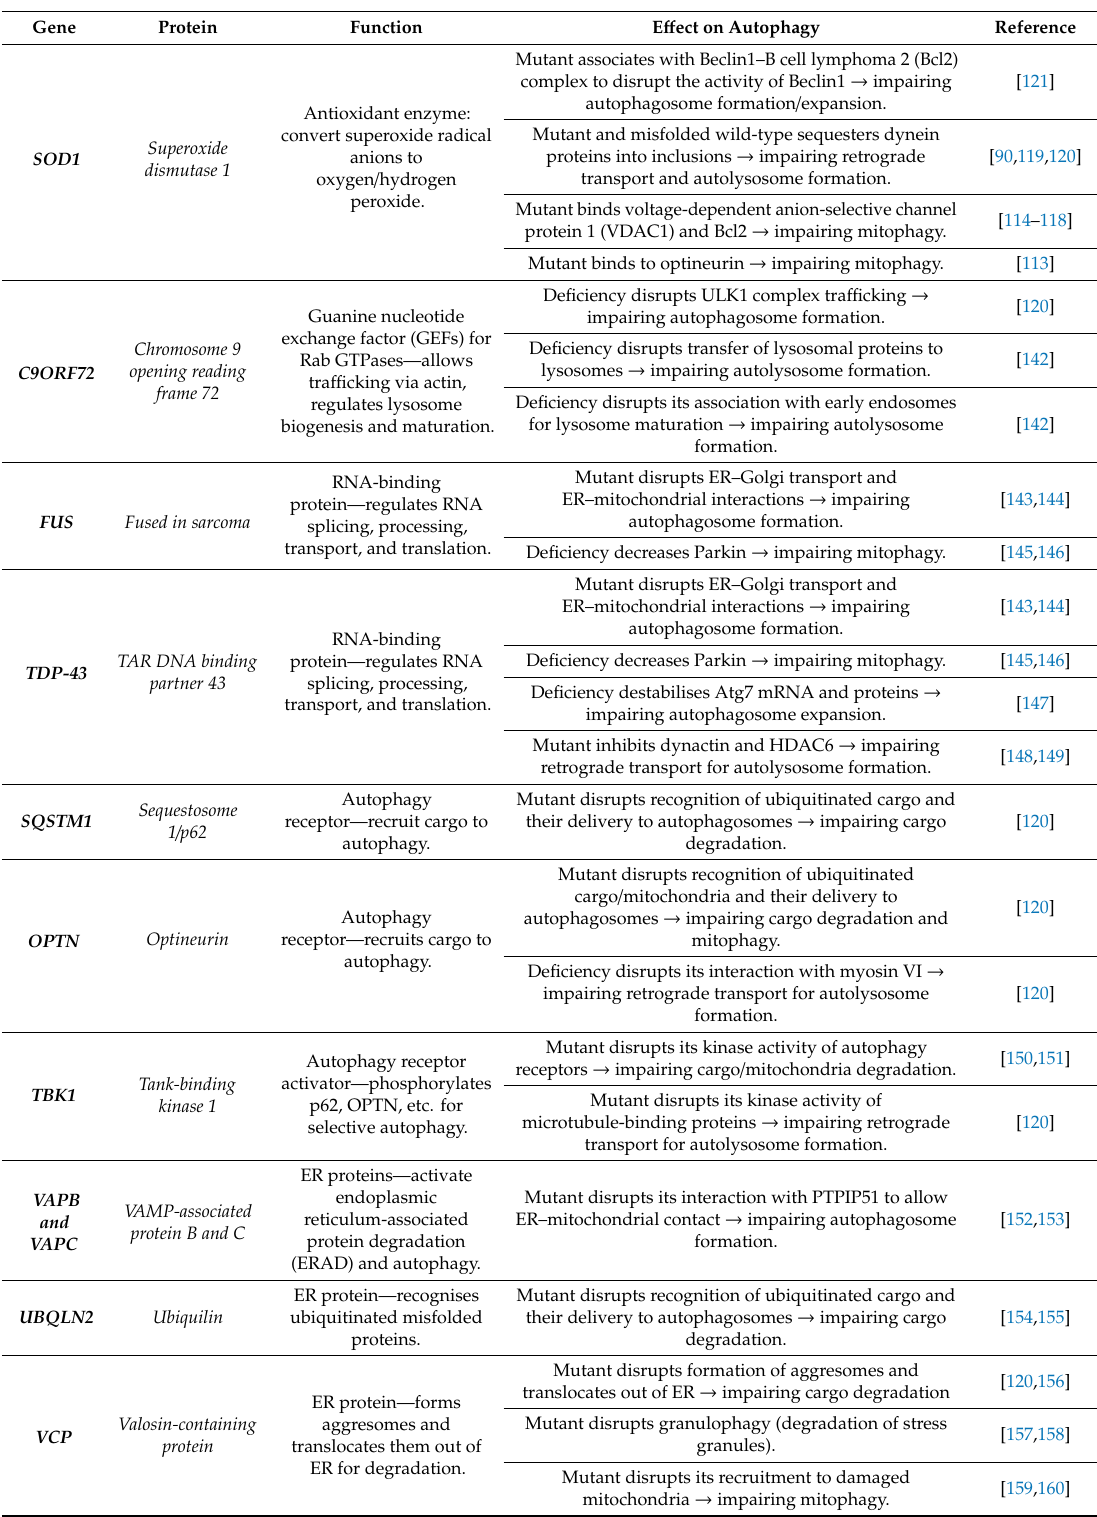
Table 1. The association between ALS genes and